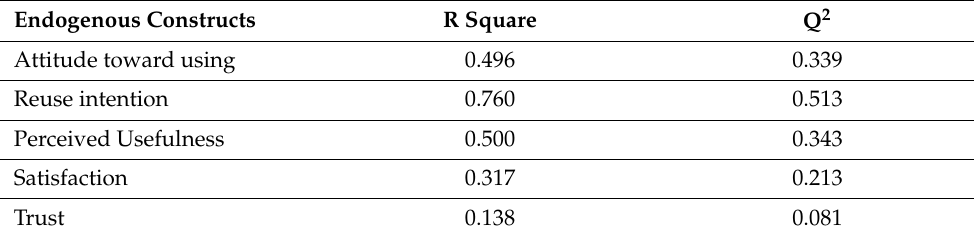
Table 3. Results of R Square and predictive relevance (Q 2